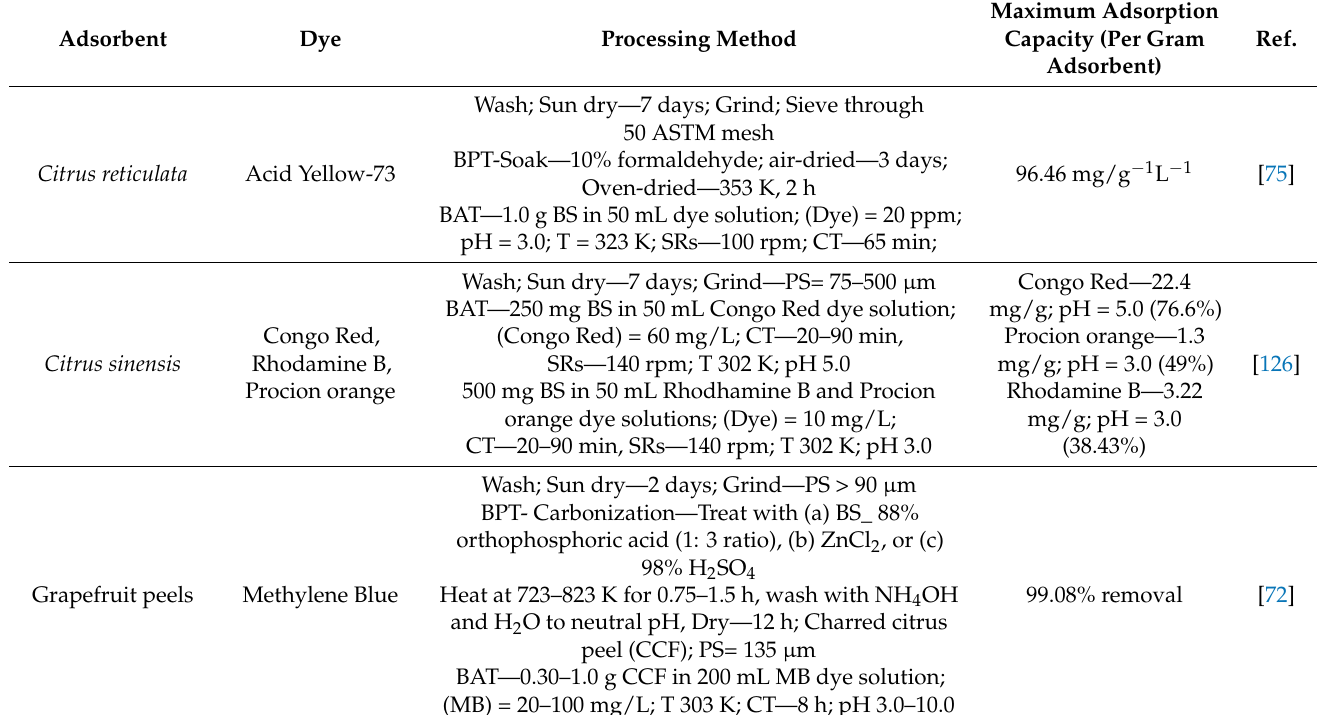
Table 4. Citrus waste reuse as bio-sorbents for the removal of poisonous dyes from